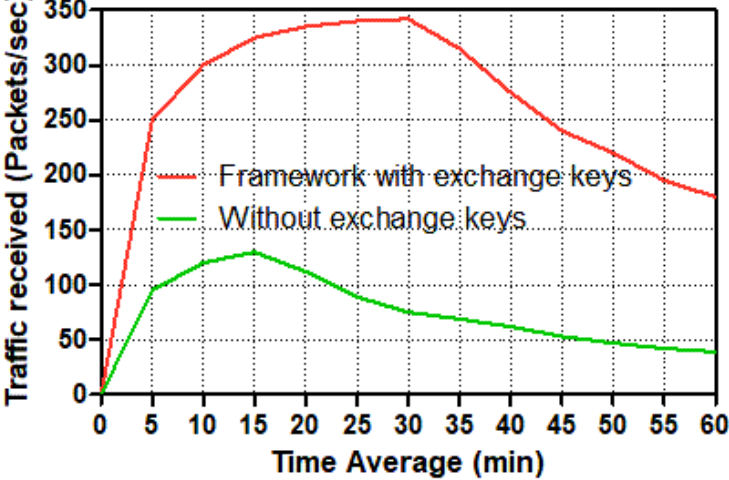
Figure 12. Traffic received (packets/s) in the control center for different